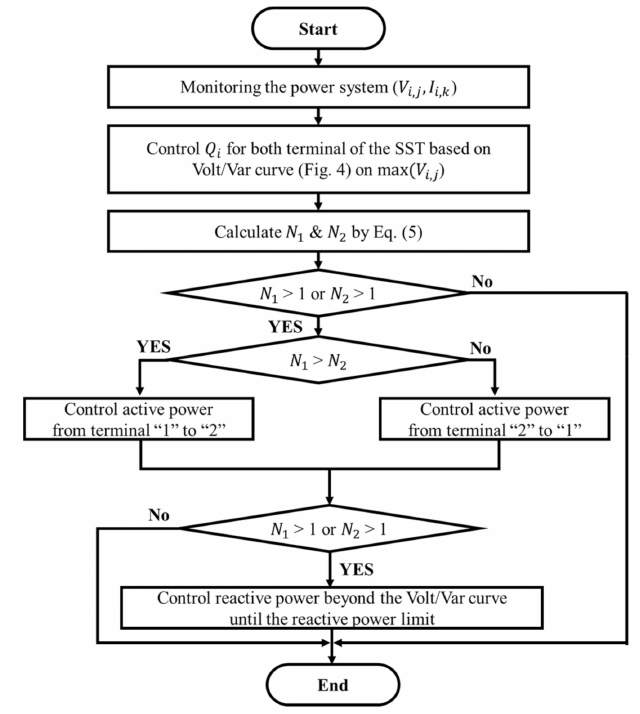
Figure 6. Flowchart for th eSST control algorithm.